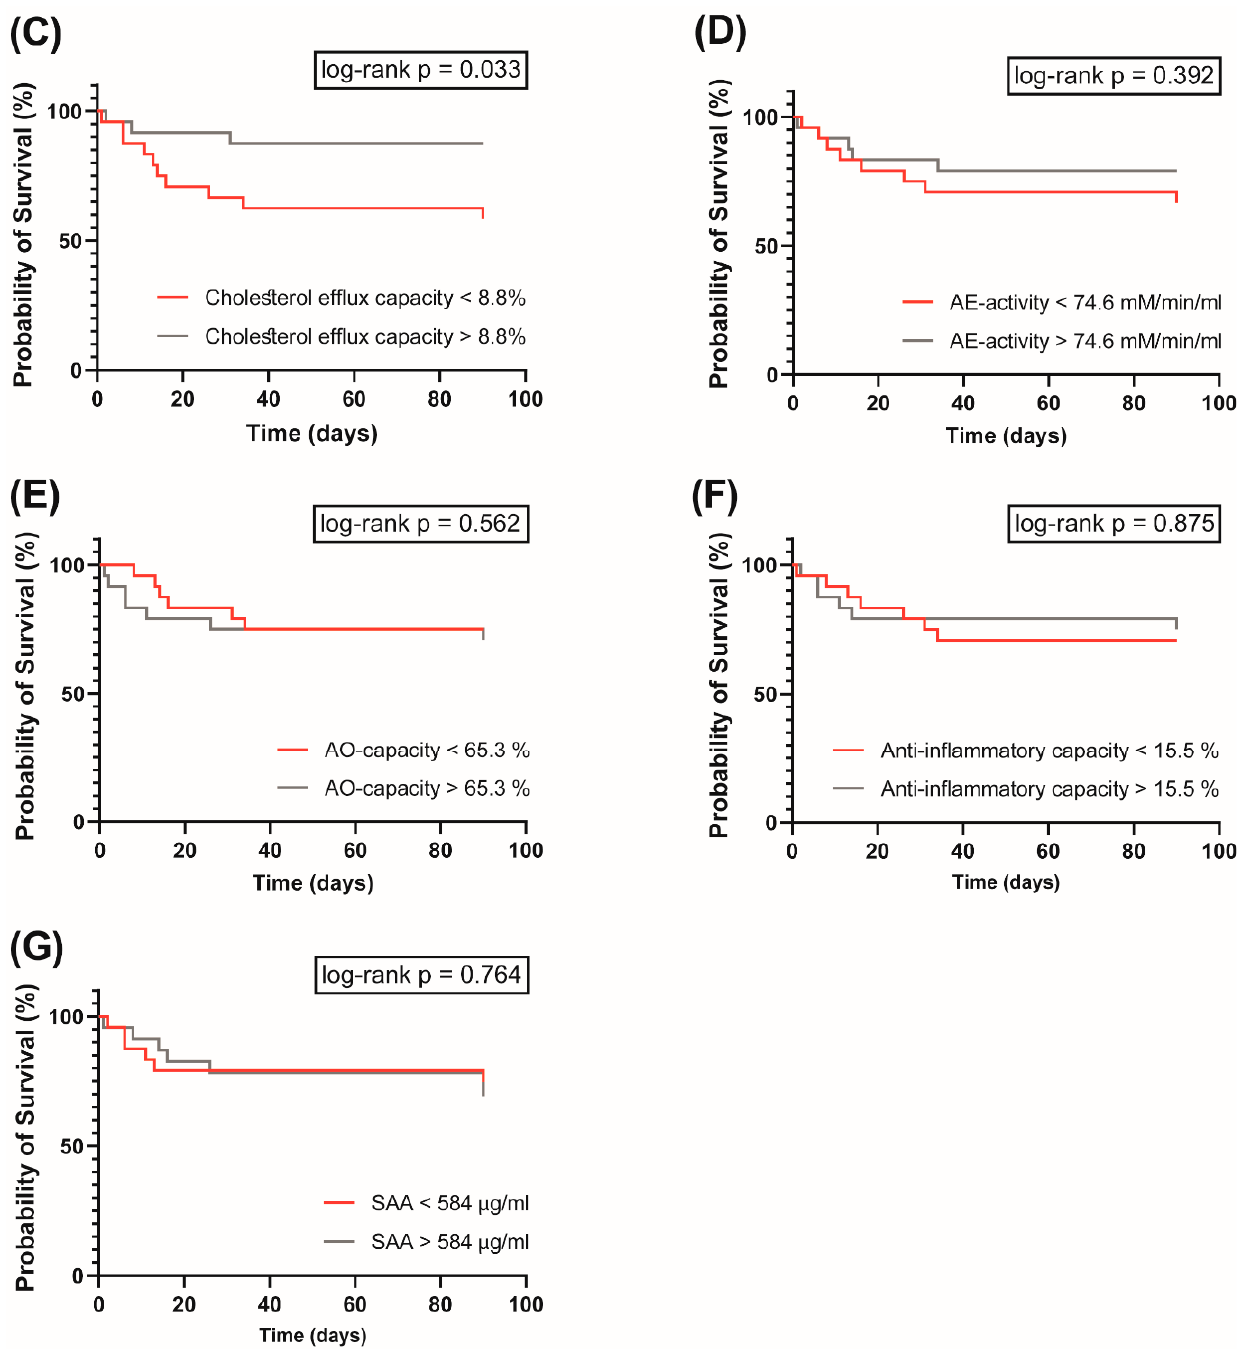
Figure 4. Kaplan–Meier analyses with subsequent log-rank test (endpoint death) in the COVID-19 cohort ( n = 48) for HDL-C ( A ), LCAT activity ( B ) cholesterol efflux capacity ( C ), AE-activity of PON1 ( D ), AO-capacity ( E ), anti-inflammatory capacity ( F ) and SAA ( G ) are shown. Patients were classified as high (grey line) or low (red line) depending on whether their HDL-related parameters were above or below the